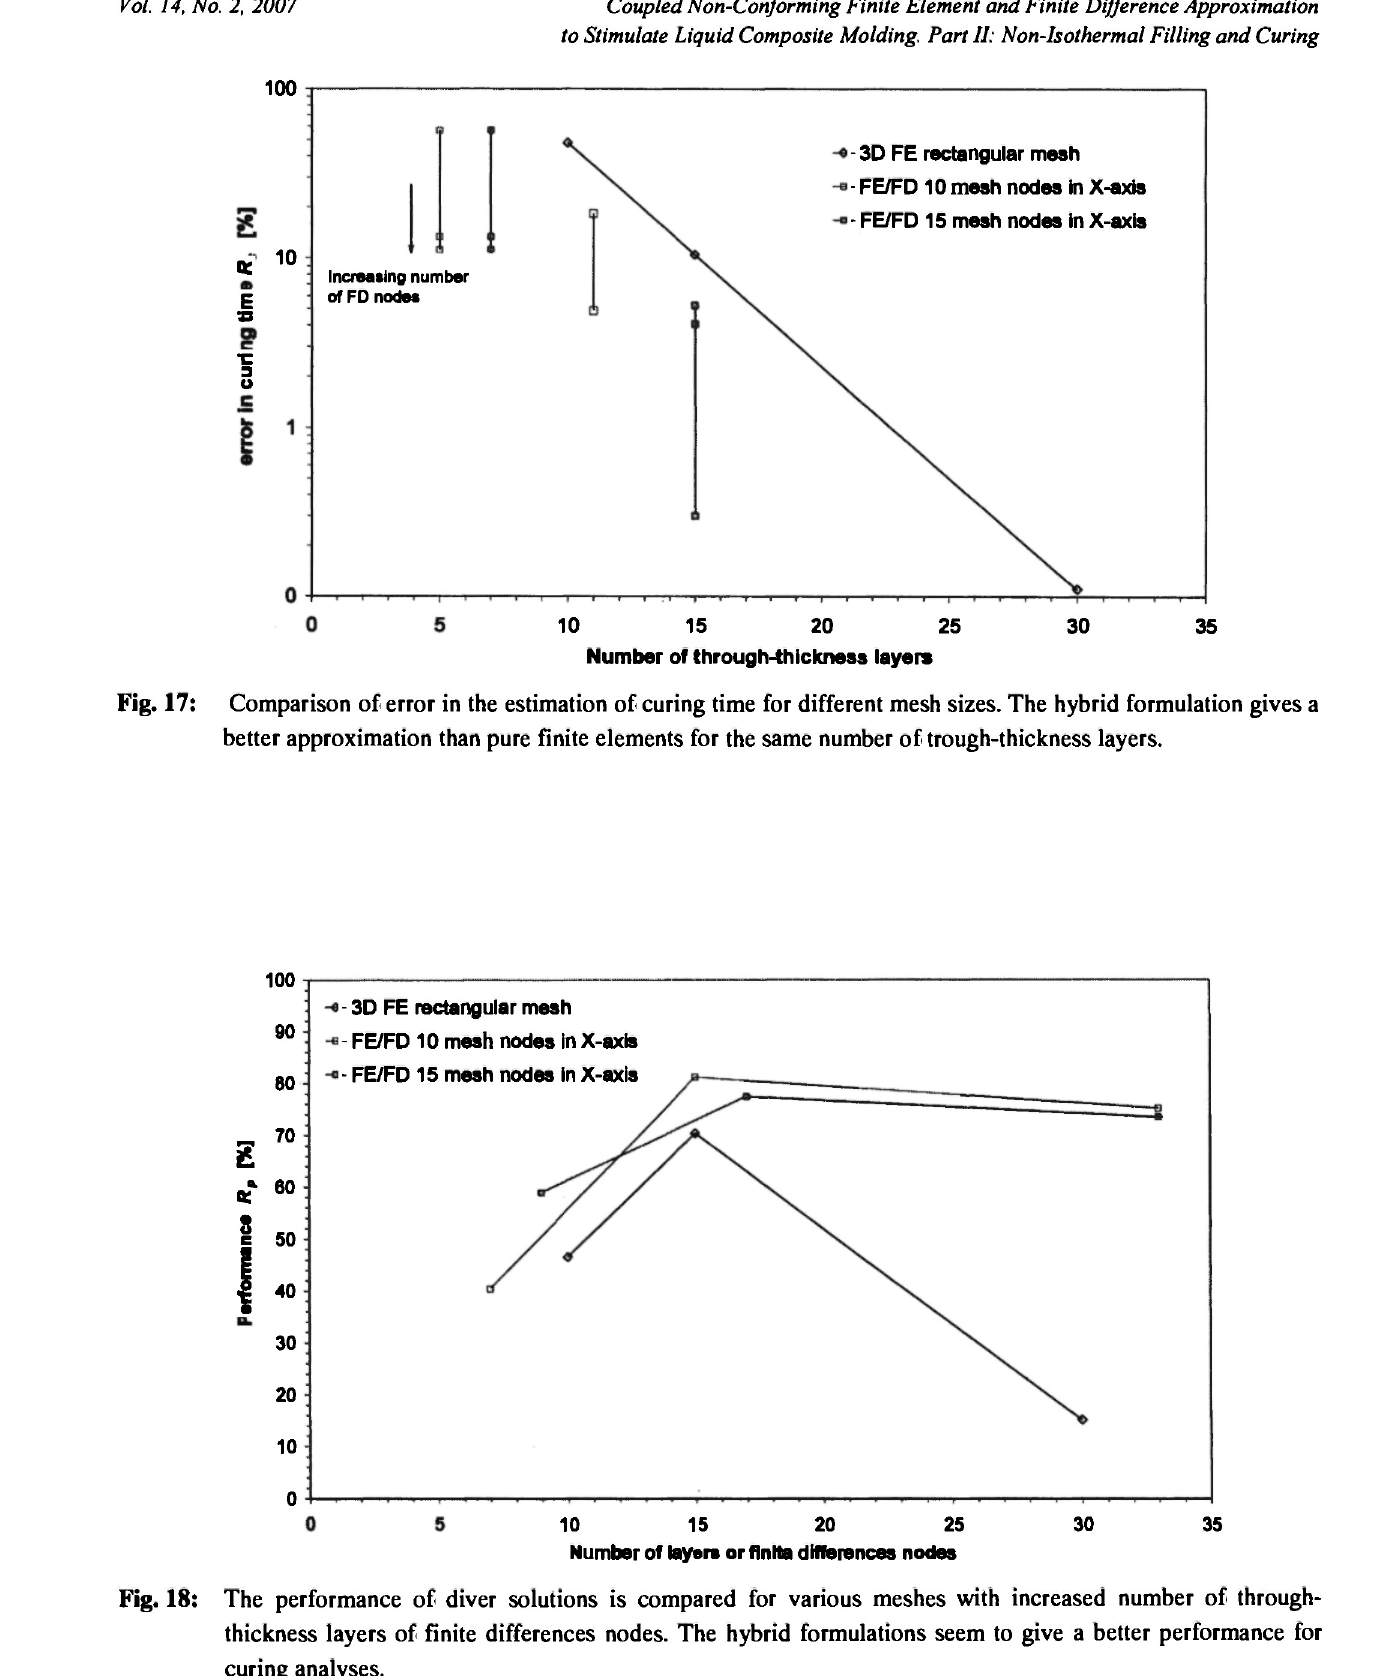
The performance of diver solutions is compared for various meshes with increased number of through- thickness layers of finite differences nodes. The hybrid formulations seem to give a better performance for curing